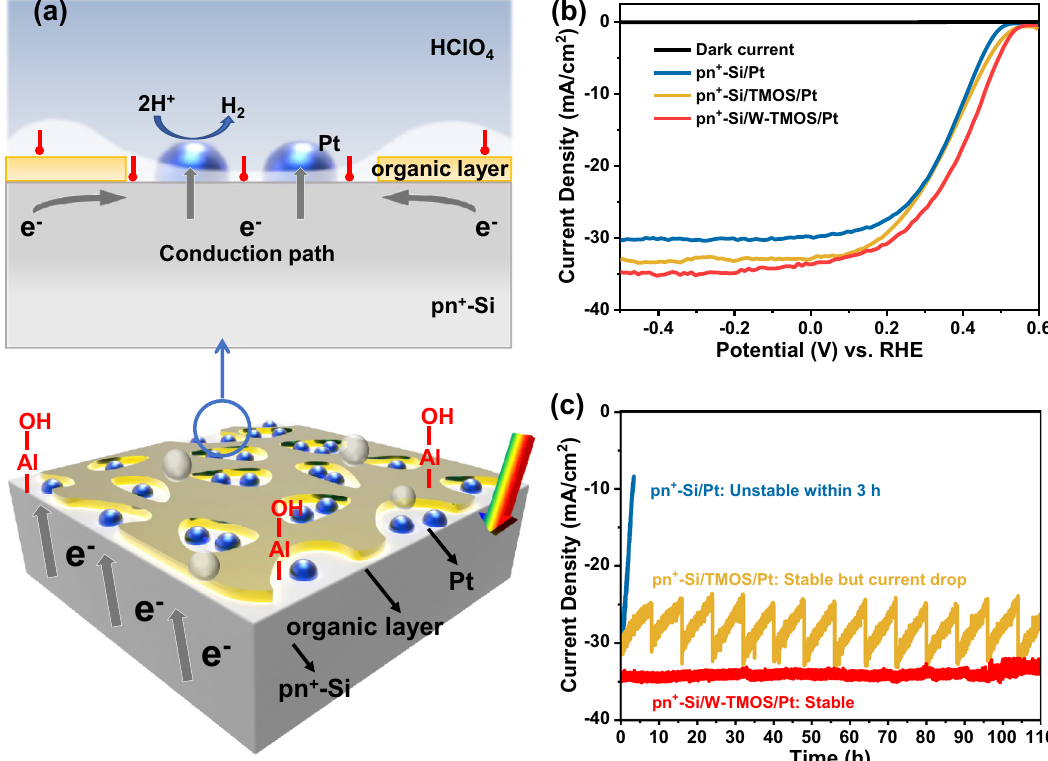
Fig. 1 | PEC performance of photocathodes protected by organic protective layers. a Electron conduction path of pyramid pn + -Si/organic layer/Pt photo- cathode. b J – V curves of photocathodes with different protective layers under AM